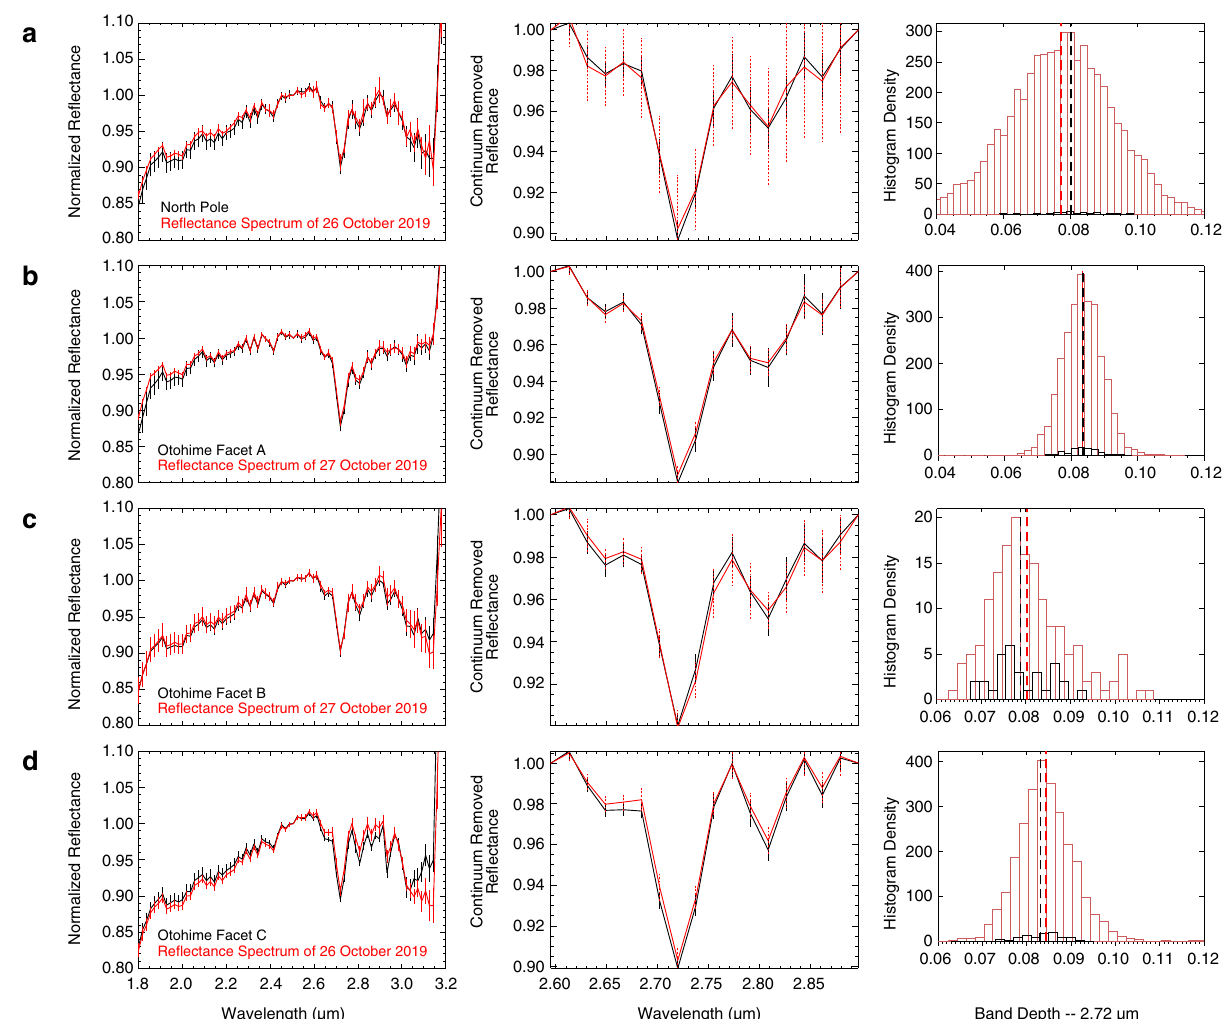
Fig. 3 Near-infrared observations for polar regions. (Left) Normalized NIRS3 re fl ectance spectra of the polar regions compared with the standard reference spectrum outside of the polar regions. The spectra are normalized at 2.5 µ m. The error bars are indicative of the standard deviation amongst the spectra used to compute the average region of interest (black) spectrum and average standard reference spectrum (red). (Middle) Detail of the 2.72- µ m feature regions. We show the continuum removed band. The continuum is removed using 2.6 µ m and 2.9 µ m as anchor points 67 . The error bars are indicative of the standard deviation amongst the spectra used to compute the average region of interest (black) spectrum and average standard reference spectrum (red). (Right) Histogram distribution of the band depth for each day ’ s observation. All spectra in the day (red), spectra of the region of interest (black). The vertical dashed lines represent the average value of each distribution. a North pole (photometrically corrected data). b Otohime Facet A (non- photometrically corrected data). c Otohime Facet B (photometrically corrected data). d Otohime Facet C (photometrically corrected